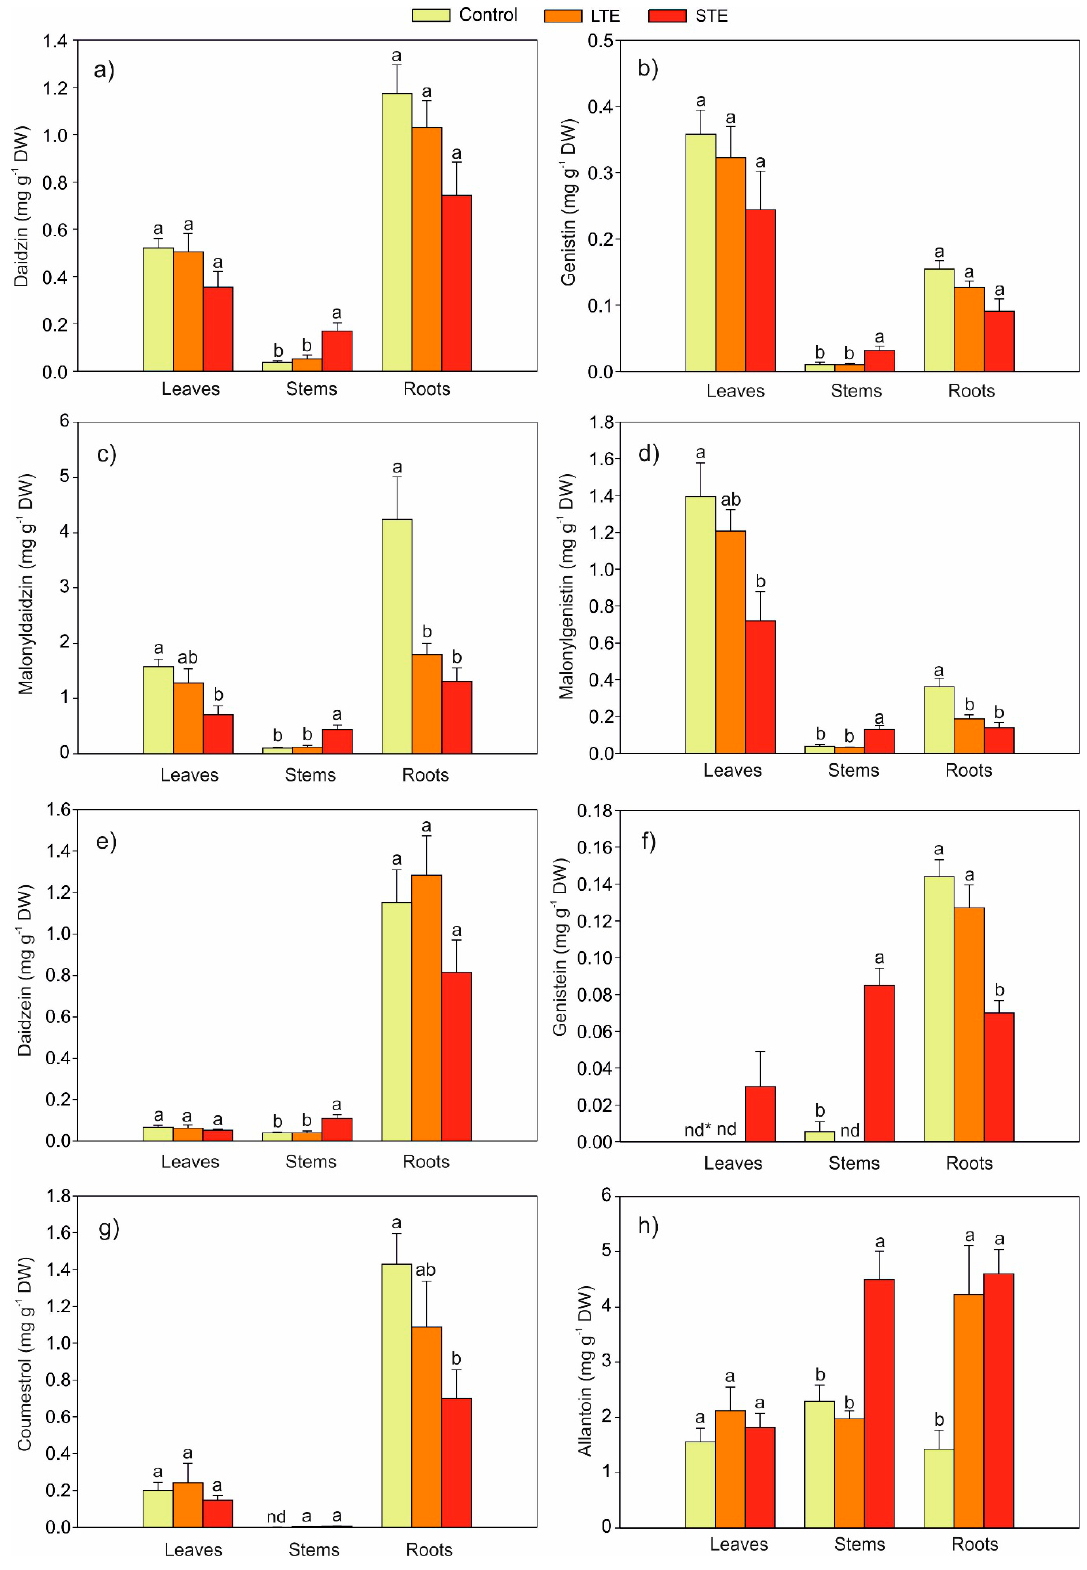
Figure 3. Mean content of phytoestrogens ( a – g ) and allantoin ( h ) in Glycine max with standard error (SE) (for each organ, n = 5). The data followed by the same letters within the same plants’ organs are not significantly different. Abbreviations: LTE, long-term exposure to Sr; STE, short-term exposure to Sr .